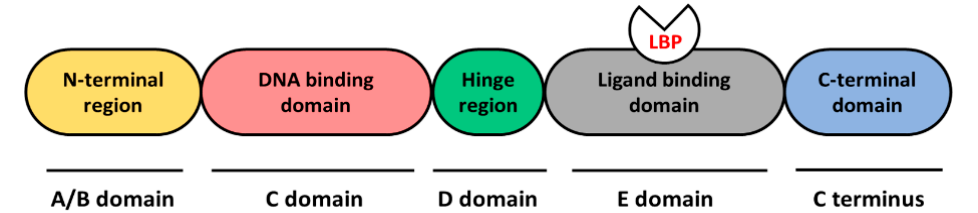
Figure 1. General structure of nuclear receptor (NR) proteins. Different domains of the NR protein are shown in different colors. A schematic representation of the ligand-binding pocket (LBP) is included in the ligand binding domain.